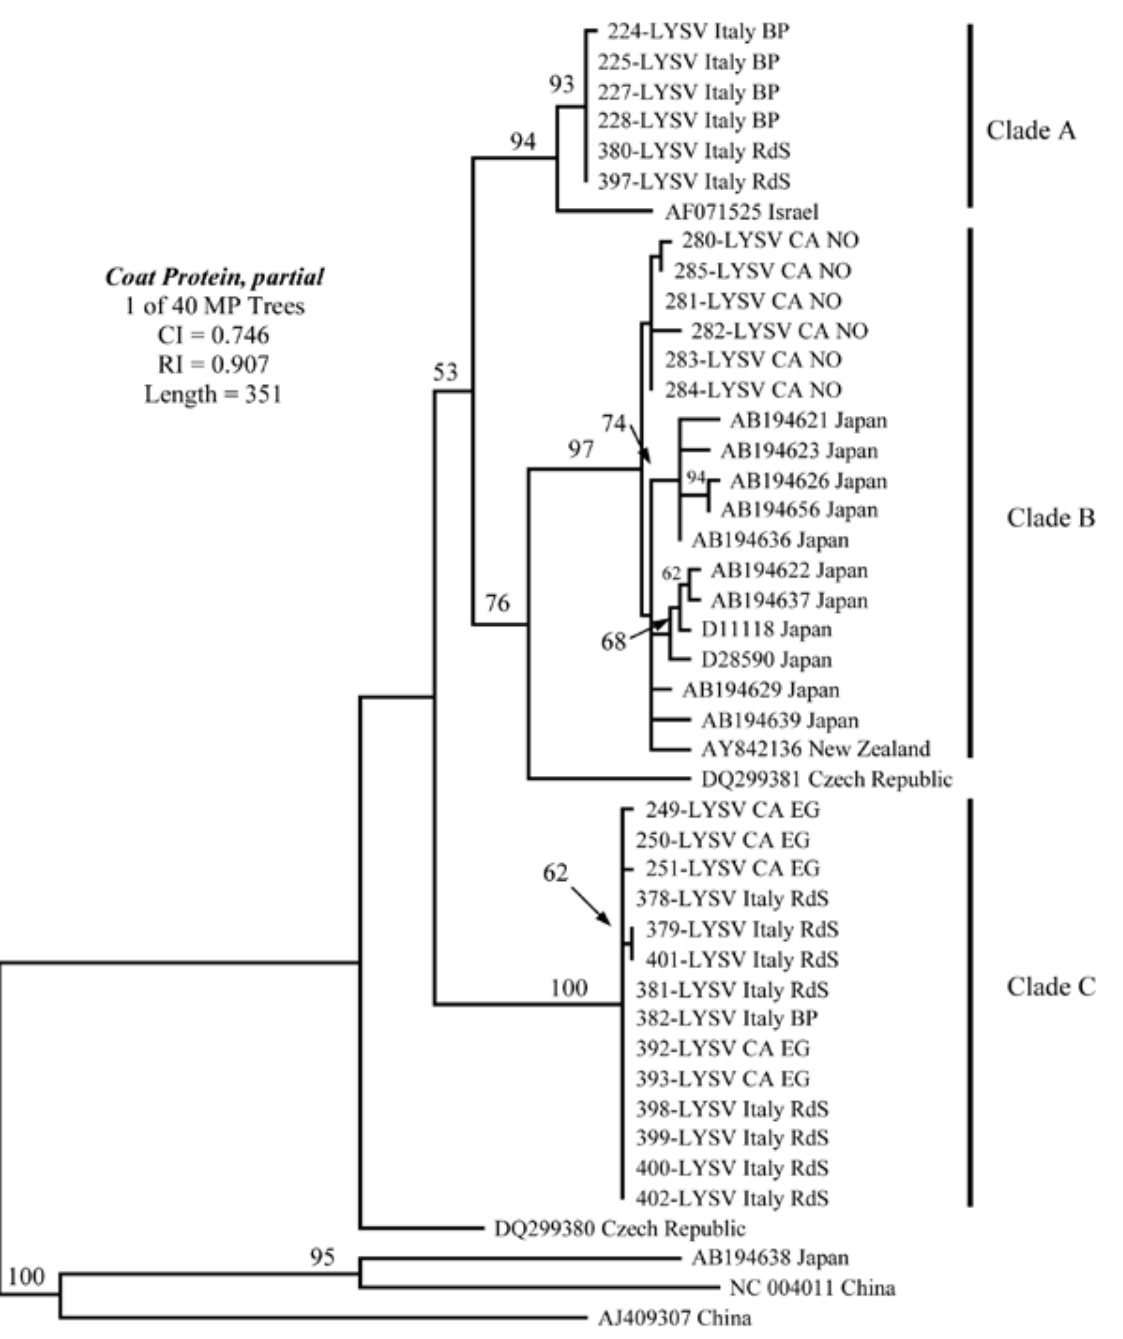
Figure 4. Maximum parsimony analyses of the coat protein gene for Leek yellow stripe virus (LYSV) isolates obtained in this study, as well as sequences from GenBank. Bootstrap support of 50% and above is indicated above nodes based on 1,000 replicates. 224-402: Serial numbering of cDNA LYSV clones, BP: ‘Bianco Piacentino’, RdS: ‘Rosso di Sulmona’, CA: Cali- fornia, NO: Non-organic, and EG: ‘Elephant’ garlic. Sequences have been deposited in GenBank under accession numbers HQ873735-